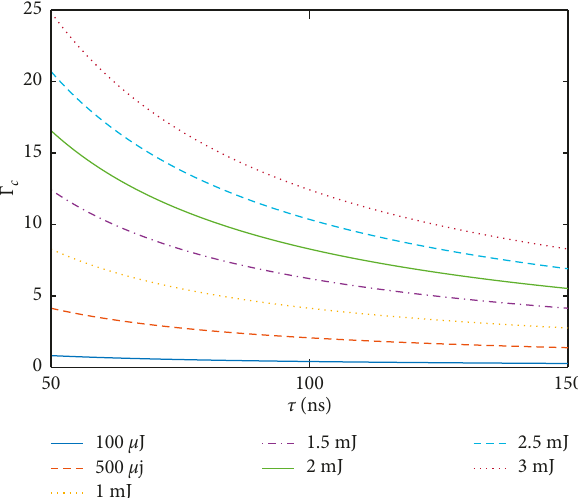
Figure 4: Coherent memory of SRS interaction as a function of pulse width for hydrogen-filled HCPCF with different pump energy levels.